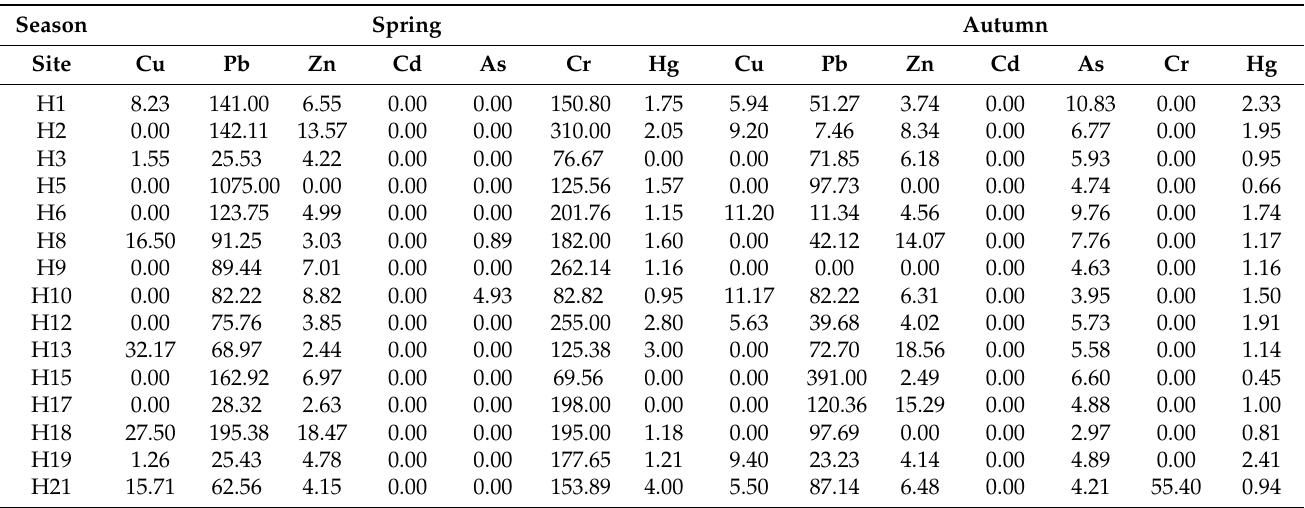
Table 2. Flowability of heavy metals in coastal Hong